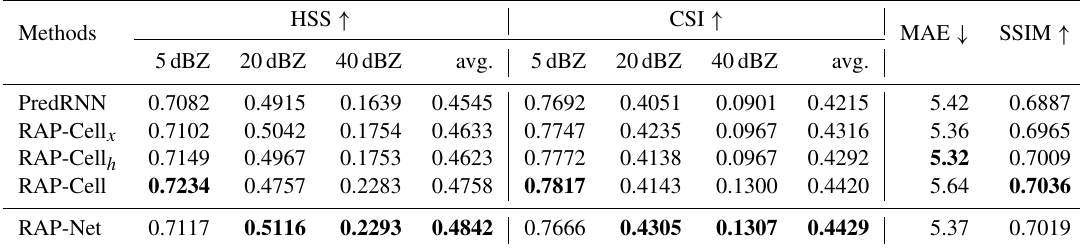
Table 3. Ablation results on RadarCIKM in terms of HSS, CSI, MAE, and SSIM. The best results are given in bold, and the second-best scores are